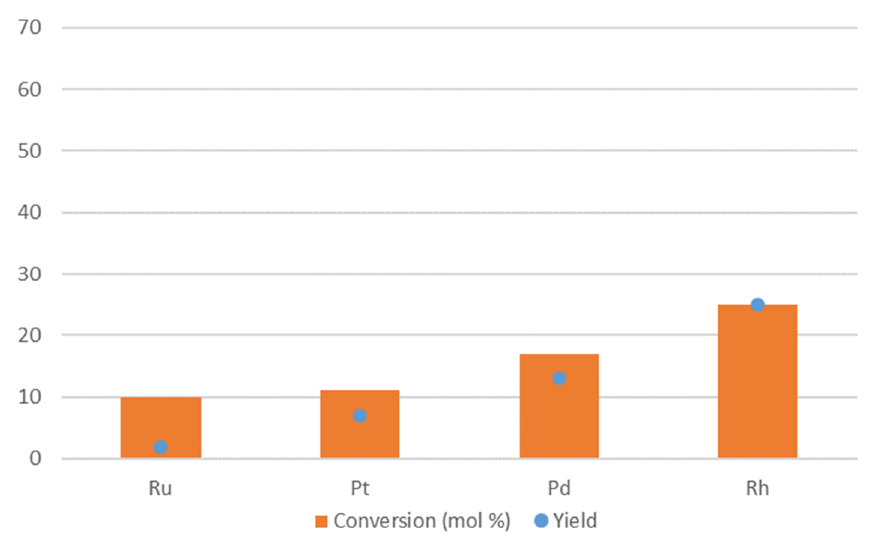
Figure 4. The conversion (mol%, orange) and yield (mol%, blue) of the hydrogenation reactions of trans , trans -muconic acid in presence of Ru, Pt, Pd and Rh NPs (metal = 0.037 mM) in water at room temperature and pressure with H 2 after 8 h of reaction.